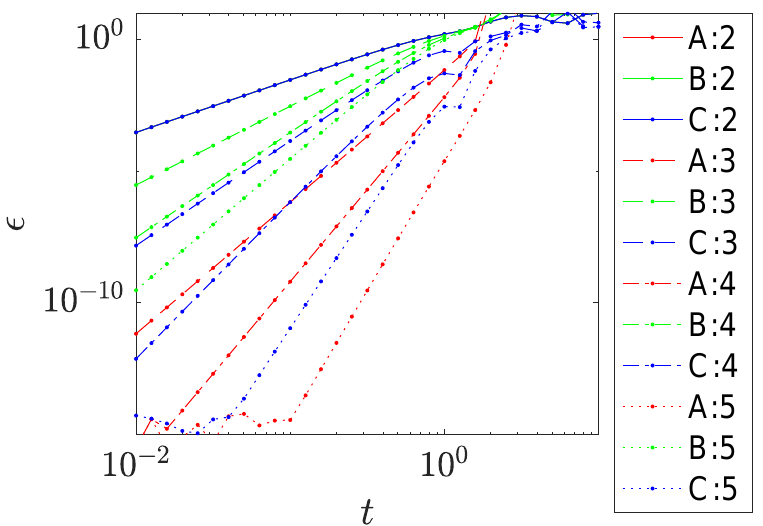
Figure 2: Relative error ε of the cluster-expansion TNO for the real-time evolution operator U ( t ) = e − iHt of the 1-D transverse-field Ising model at g = 1 on a periodic chain of 11 sites. We show results of the cluster-expansion TNO of type A,B and C with cluster size c = 2,3,4,5, as a function of time t